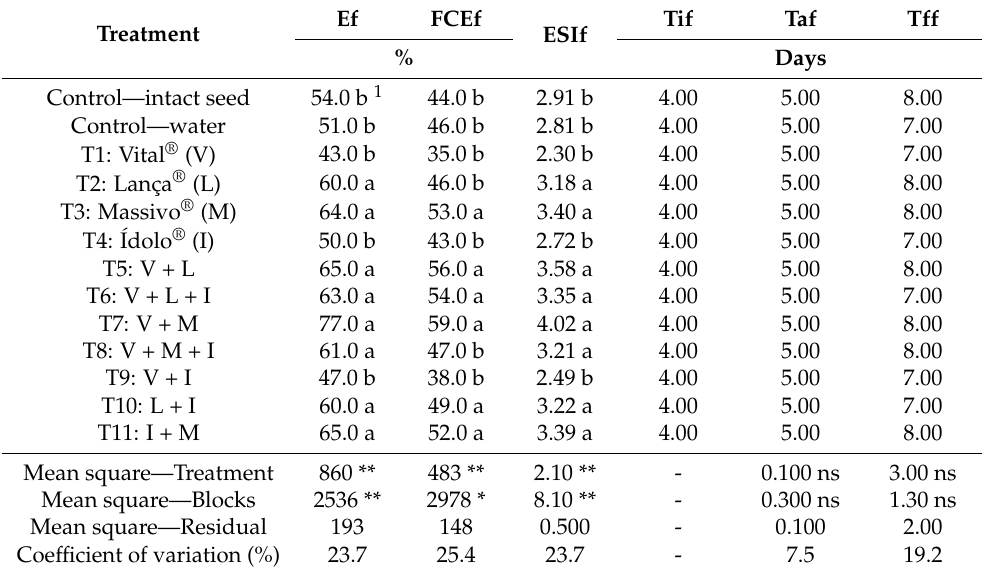
Table 3. Seedling emergence in the field (Ef), first count (FCEf), and seedling emergence speed index in the field (ESIf) at initial, average, and final emergence times of soybean NS7667 IPRO seedlings in the field from different seed treatments. Jata í , GO, Brazil,